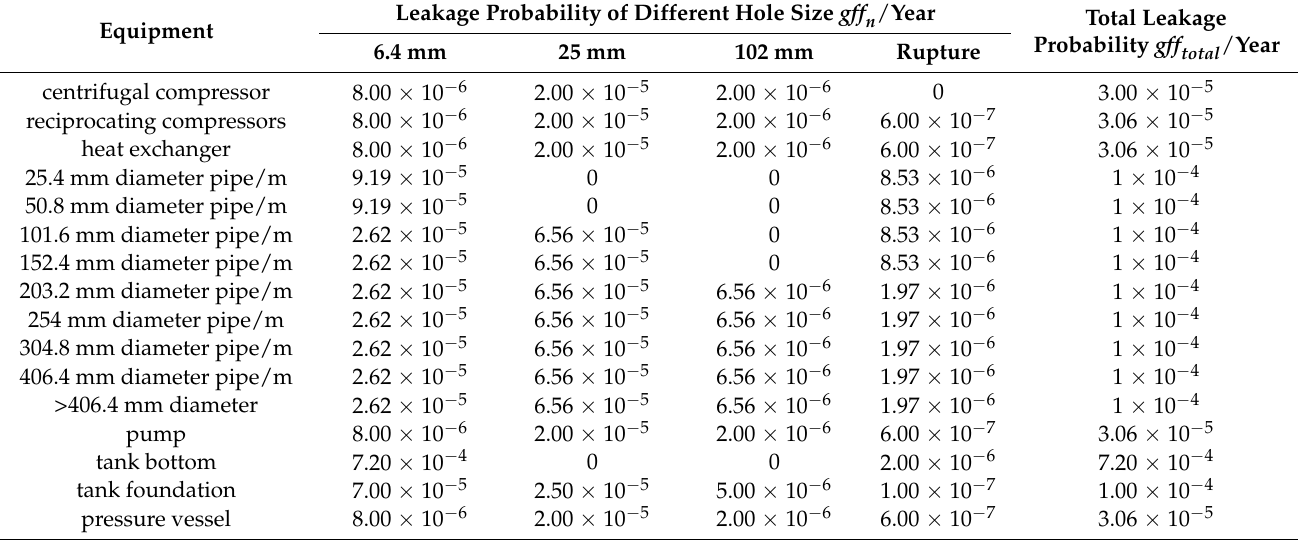
Table 5. Leakage probability of equipment and